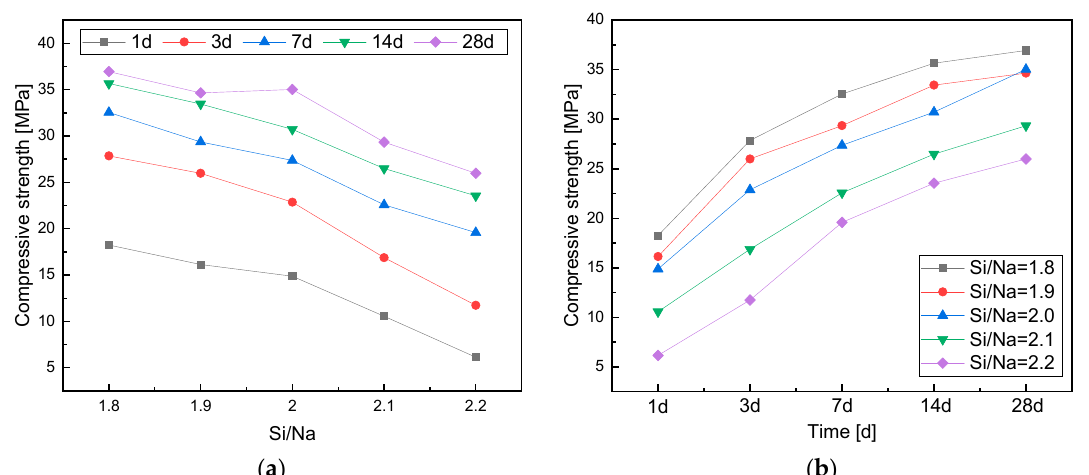
Figure 5. ( a ) A chart of the changes in compressive strength with Si/Na ratio; ( b ) a chart of the changes in compressive strength with age.